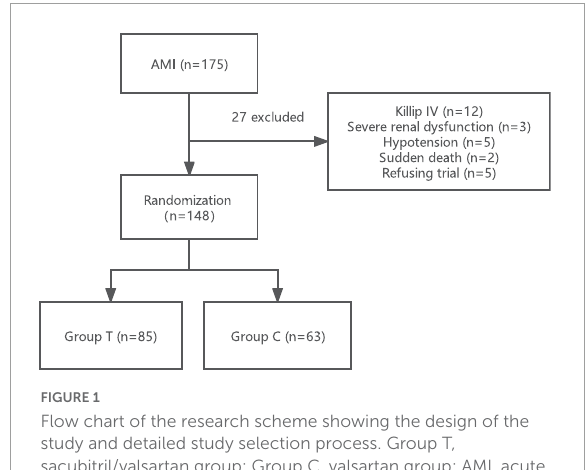
FIGURE1 Flow chart of the research scheme showing the design of the study and detailed study selection process. Group T, sacubitril/valsartan group; Group C, valsartan group; AMI, acute myocardial